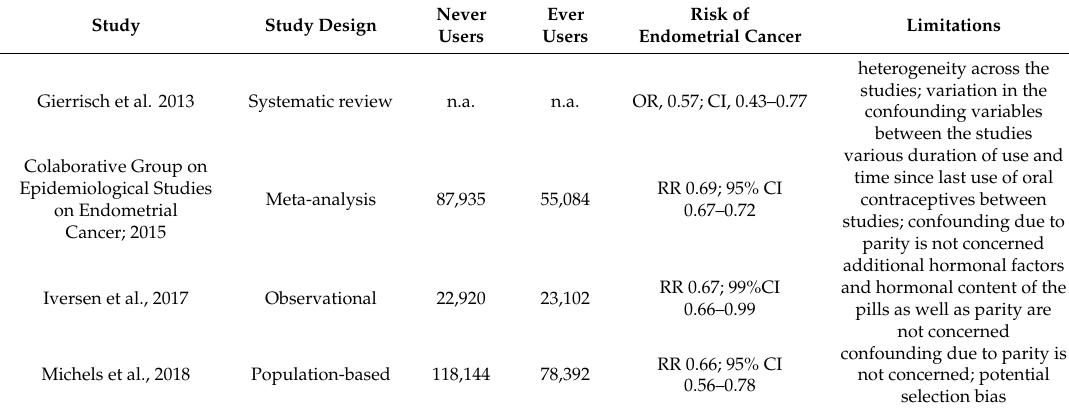
Table 2. Characteristics of the studies included in this review regarding the use of oral contraceptives and endometrial cancer